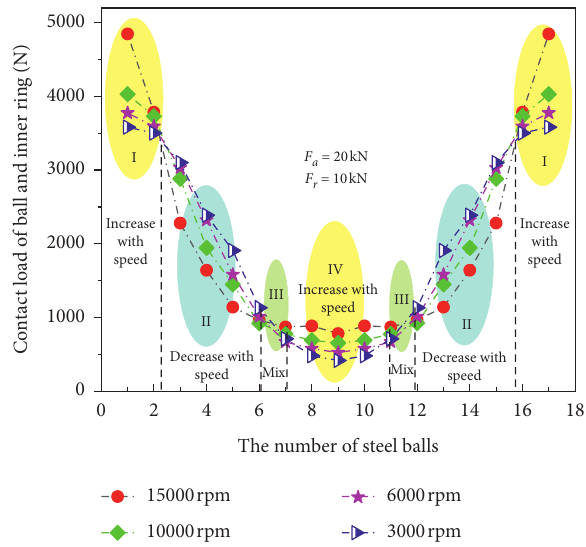
Figure 19: Contact force between ball and inner ring under axial force and radial